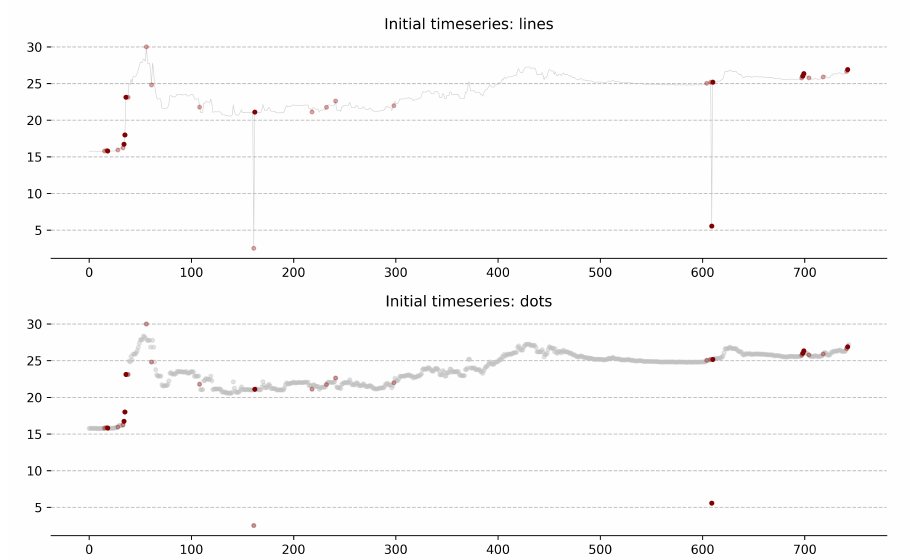
Figure 8. Non-seasonal time-series with outliers. Anomalies were found with an anomaly likelihood threshold of 0.9.